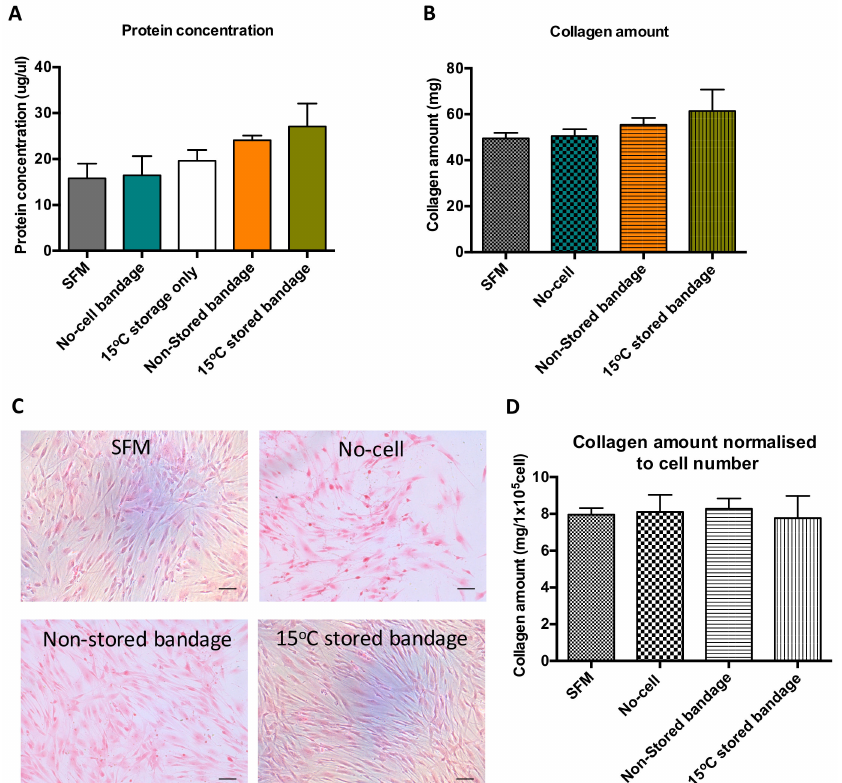
Figure 3. Ad-MSCs bandages stored at 15 ◦ C exhibited increase in soluble protein concentration and collagen amount. ( A ) Assessment of soluble protein concentration, ( B ) collagen amount, ( C ) representative images of collagen stained CSCs cultures, and ( D ) collagen amount normalised to CSC number. SFM, Serum-free media; no-cell bandages, alginate bandages formed without Ad-MSCs; non-stored bandage, bandages used immediately following formation; and 15 ◦ C stored bandages, bandages used following 72 h storage. Values are presented as mean (SEM) of three separate corneal stromal cells